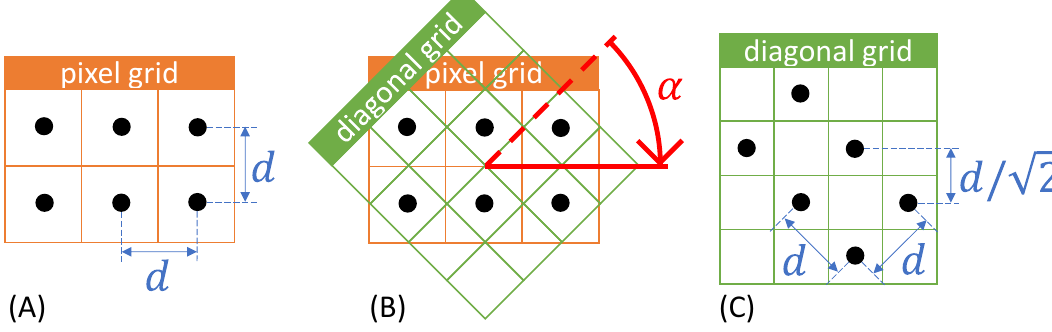
Figure 3. Lossless image rotation by α = 45 ◦ to a diagonal grid. ( A ) Image content on a pixel grid. ( B ) Superposition of a rotated diagonal grid. ( C ) Resulting rotated image content.